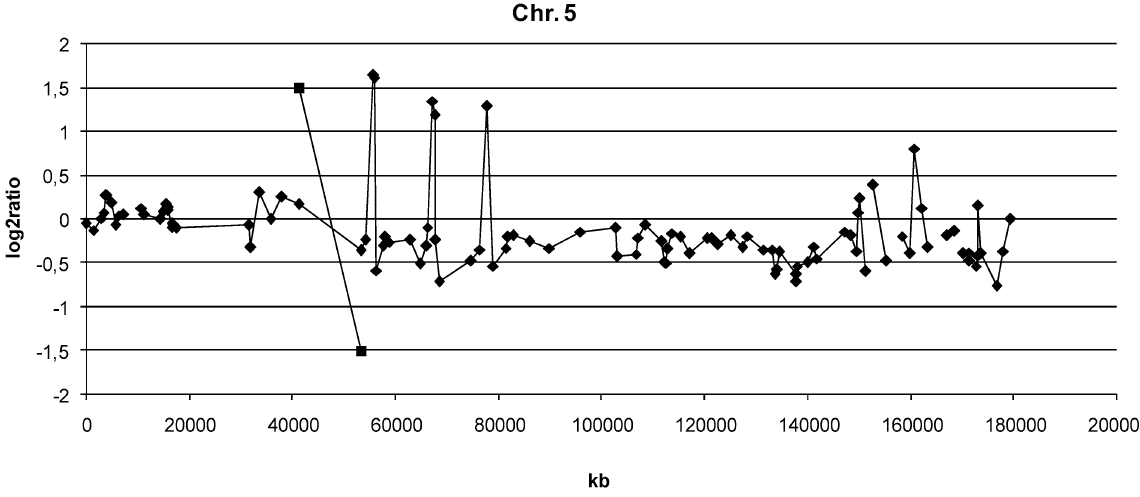
Fig. 2. Although amplifications are rare in PT, this malignant PT showed 3 amplifications on proximal 5q. Shown are the normalized log 2 ratios of clones on chromosome 5 ordered by position in the genome. Copy number loss was seen in between the amplifications. The distal peaks on 5q were counted as a gain. The vertical bar represents the location of the